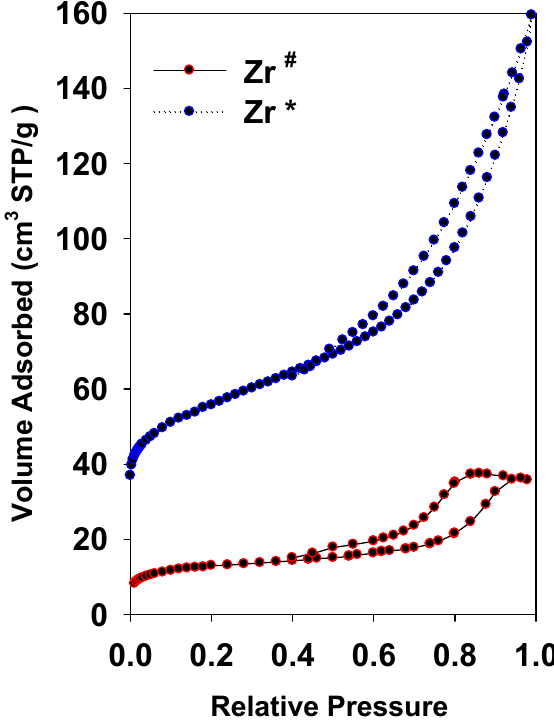
Figure 6. Nitrogen ‐ adsorption isotherms for Zr # and Zr* samples; top isotherm is shifted 40 cm 3 STP/g from bottom one. STP/g from bottom